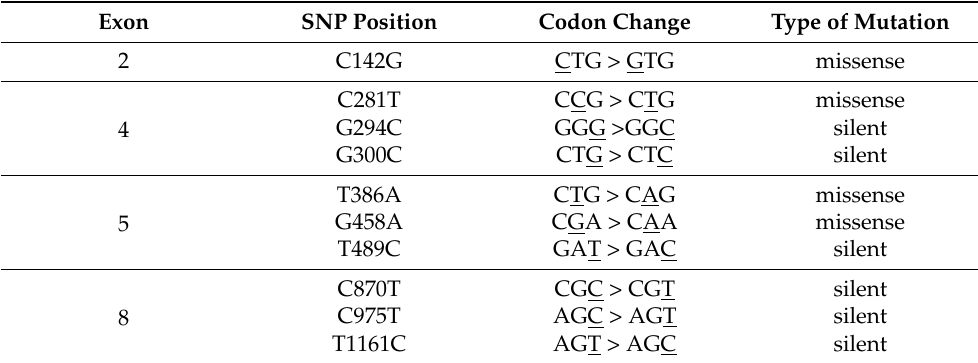
Table 3. Single nucleotide polymorphisms (SNPs) found in four exons of the coagulation factor F7 gene in the Asian elephants evaluated in this study. SNPs are listed according to their position, alteration in the codon, and type of